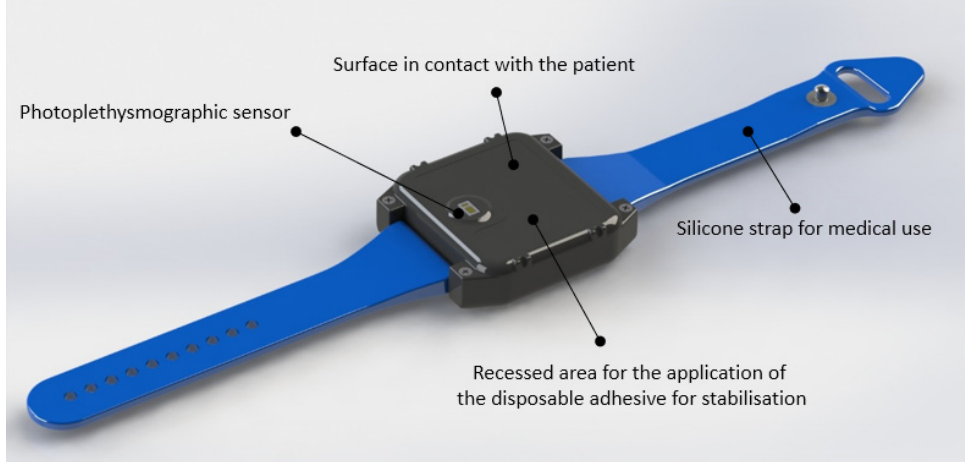
Figure 1. View of the wearable BrOxy M. The cover of the device is in contact with the subject and integrates the photoplethysmographic sensor and the recessed area for the application of the disposable adhesive (medical grade) used to stabilize the fixing of the sensor.